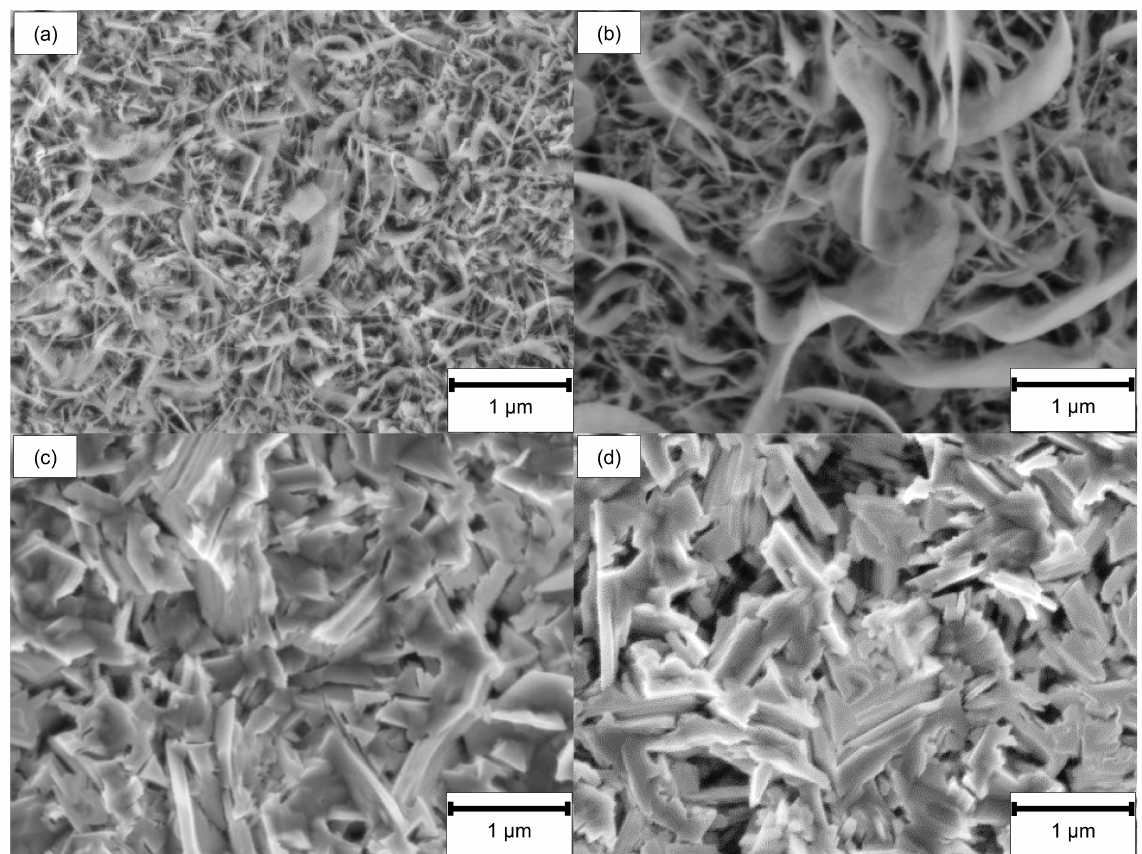
Figure 9. SEM top-view images after oxidation of ( a ) ground, ( b ) LCM-H 3 PO 4 -6W, ( c ) LCM-NaNO 3 -6W and ( d ) LCM- NaNO 3 -18W 42CrMo4 steel at 500 ◦ C for 20